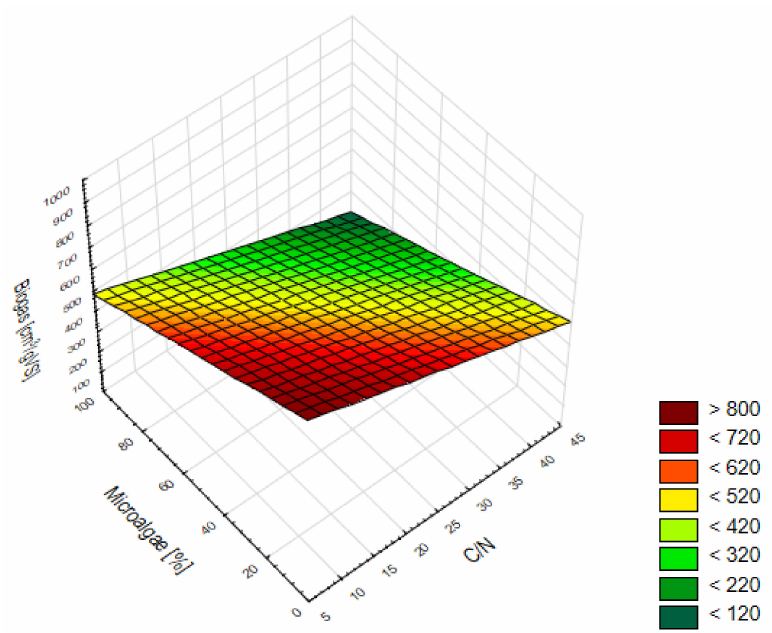
Figure 5. Forecasted plane-plotted correlation between C/N ratio or microbial share and biogas